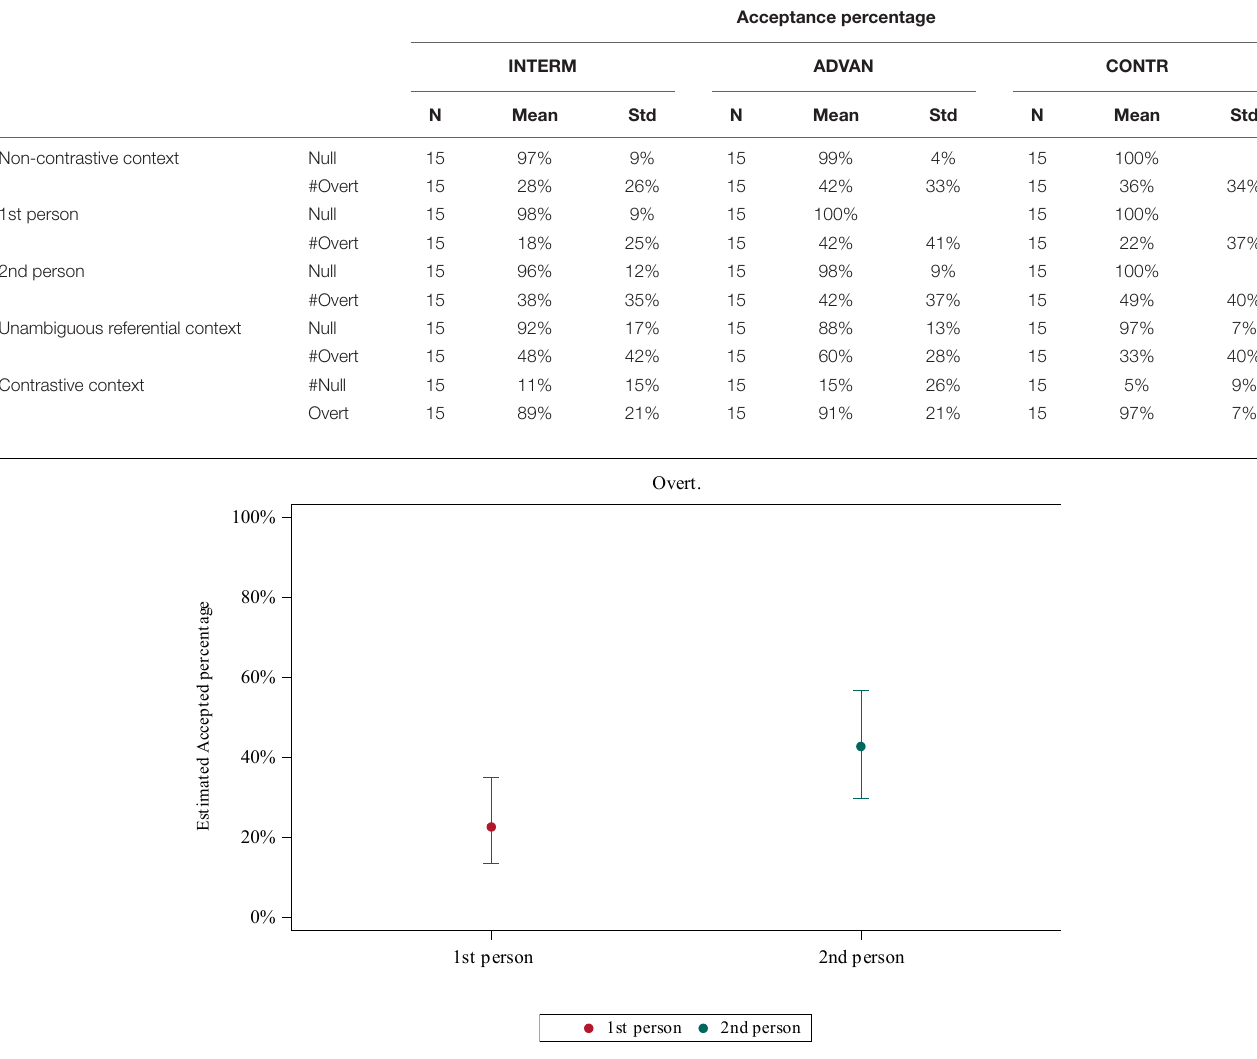
TABLE 2 | Overall means and Standard Deviation in the contexts of Experiment 1.